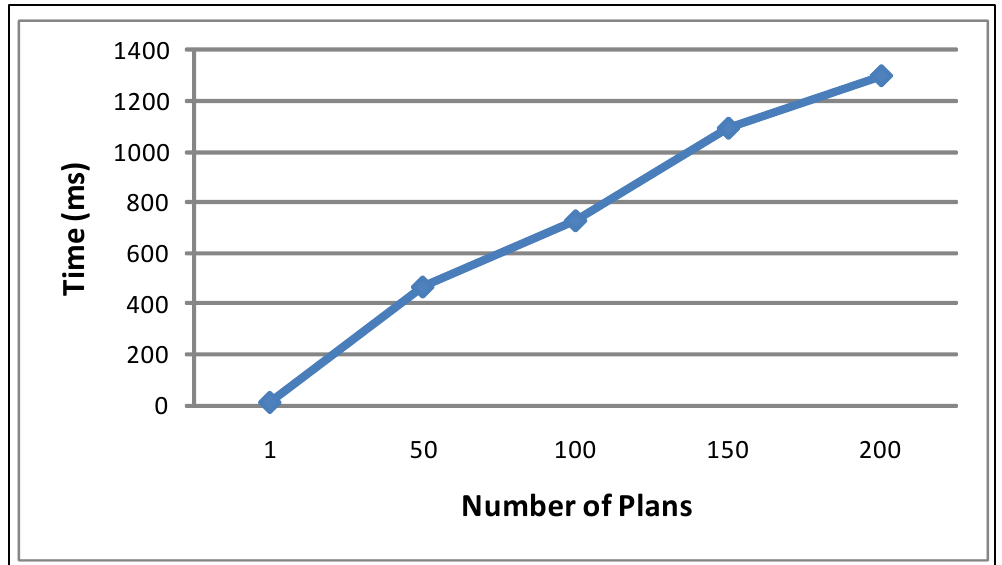
Figure 10. Time that FamiWare takes for finding and reading a